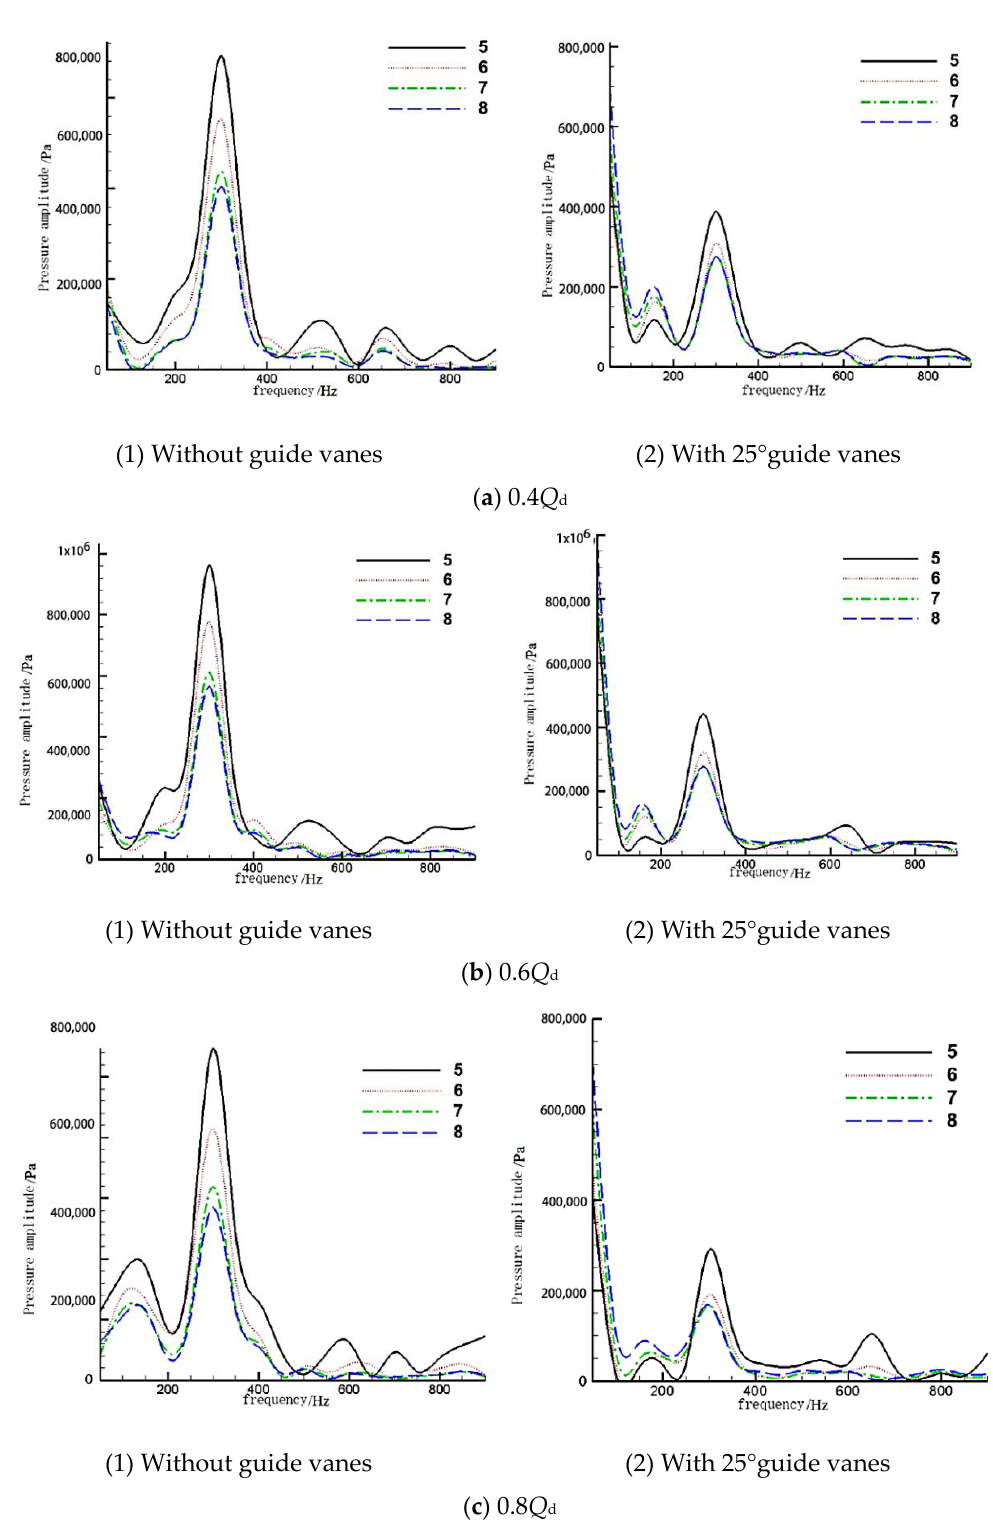
Figure 16. Frequency domain diagram of pressure pulsation in section VIII for different flow rates: ( a ) 0.4 Q d , ( b ) 0.6 Q d , ( c ) 0.8 Q d.